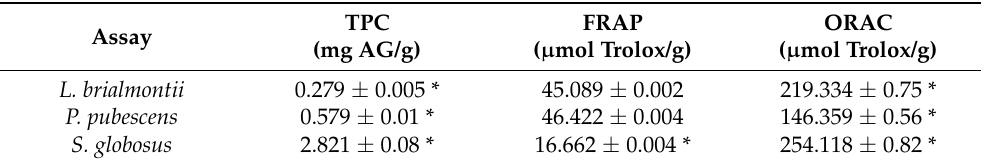
Table 4. Total phenolic content (TPC) and antioxidant activity (FRAP; ORAC) of Lecania brialmontii , Pseudephebe pubescens and Sphaerophorus globosus